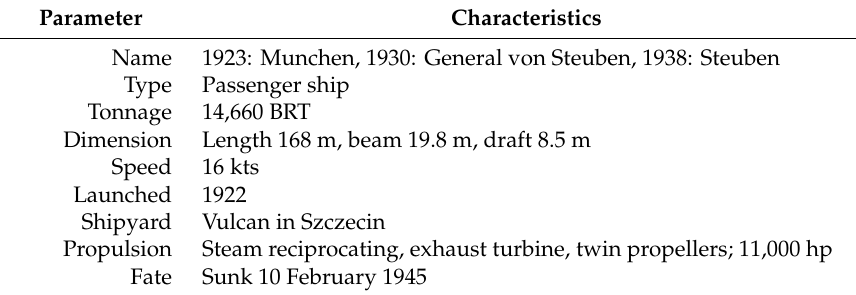
Table 1. Characteristics of passenger liner General von Steuben .